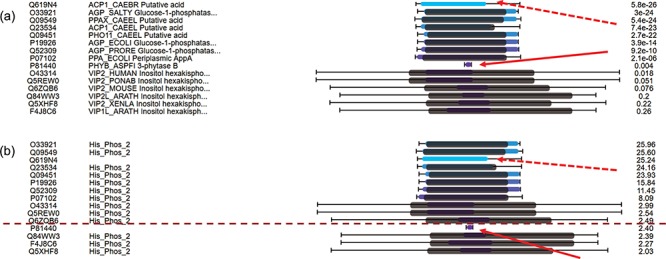
C-value to re-order hits for easy classification of true/false hits. (a) Domain alignments along with sequence alignments in the view of multiple hits ordered by E-values. The first column from the left side refers to the accession numbers of hits, the second column refers to the protein descriptions, the third column virtualizes the alignments and the last column indicates the E-values of the hits. (b) Domain alignments along with sequence alignments in the view of multiple hits re-ordered by C-values. The first column from the left side refers to the accession numbers of hits, the second column refers to the protein domains, the third column virtualizes the alignments and the last column indicates the C-values of the hits.